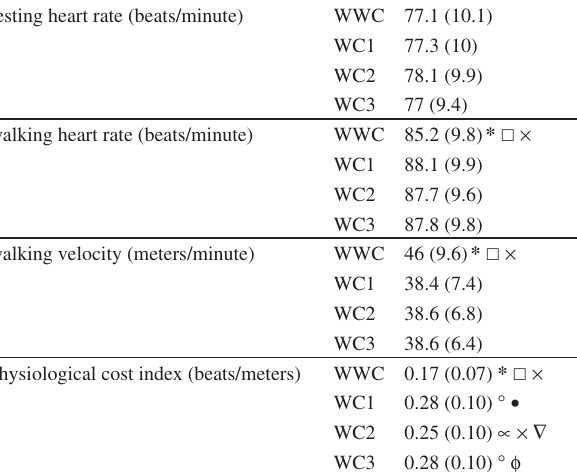
Table 2 - RHR, WHR, WV and PCI measurements (mean ± SD) for patients with knee osteoarthritis while walking with and without canes